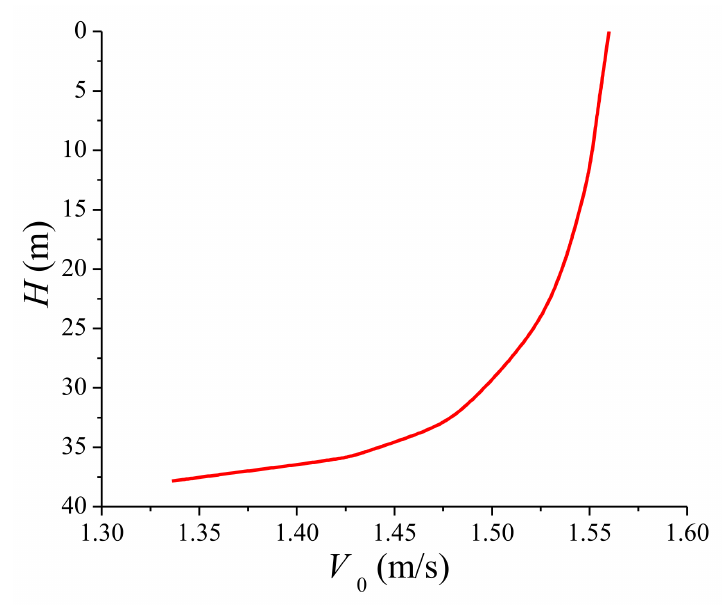
Figure 6. The velocity varies with water depth.